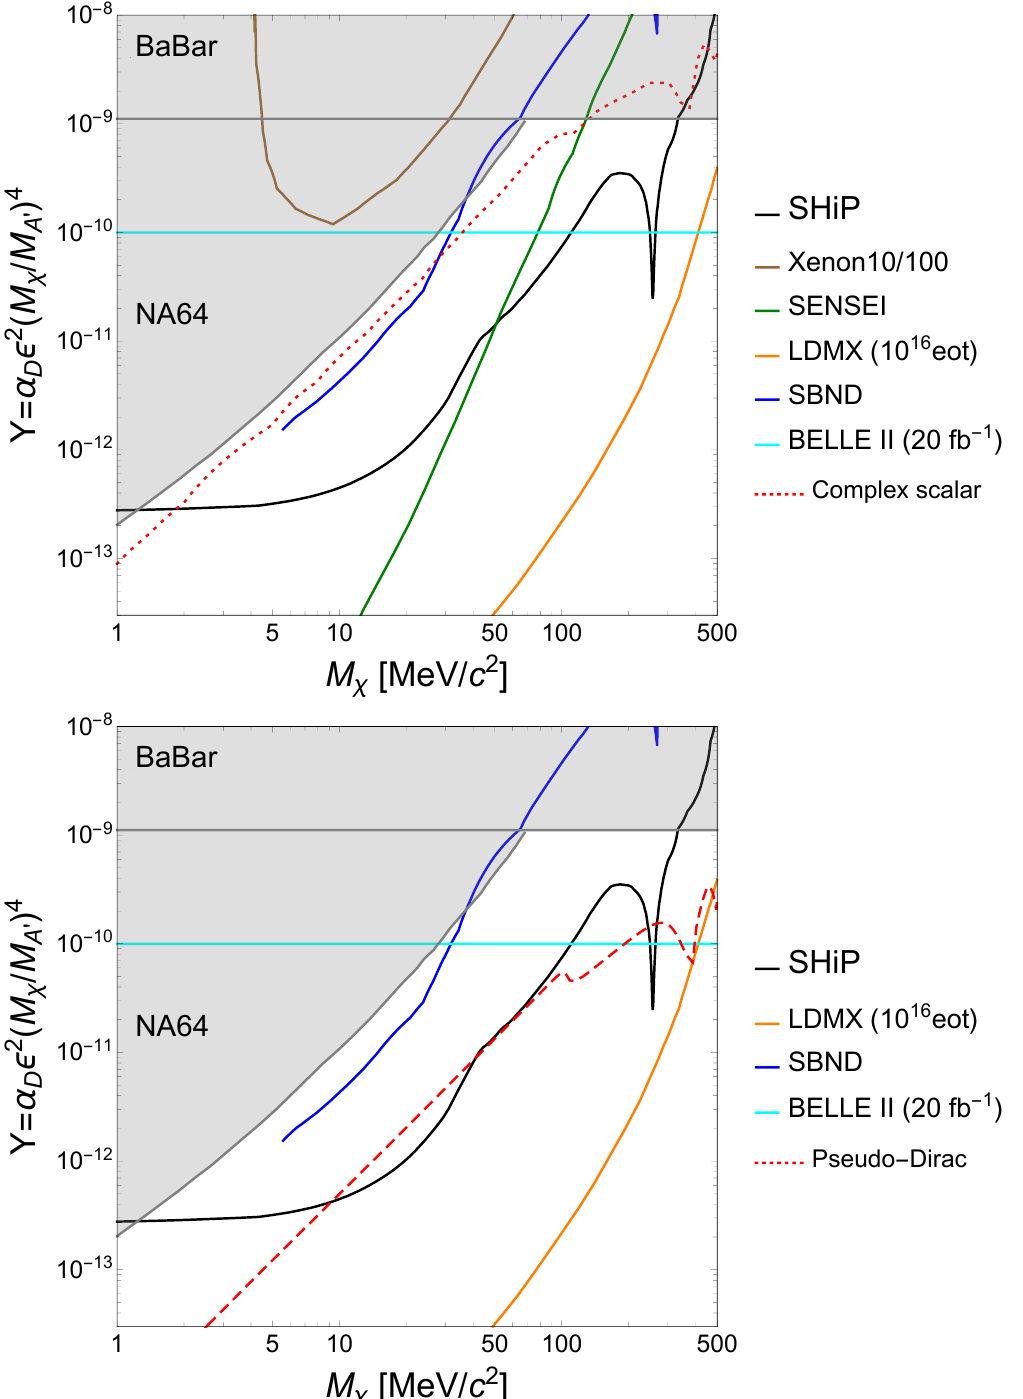
Figure 14. Comparison of existing and projected limits among the SHiP and other experiments as taken from ref. [80] for scalar (top panel) and Pseudo-Dirac dark matter (bottom